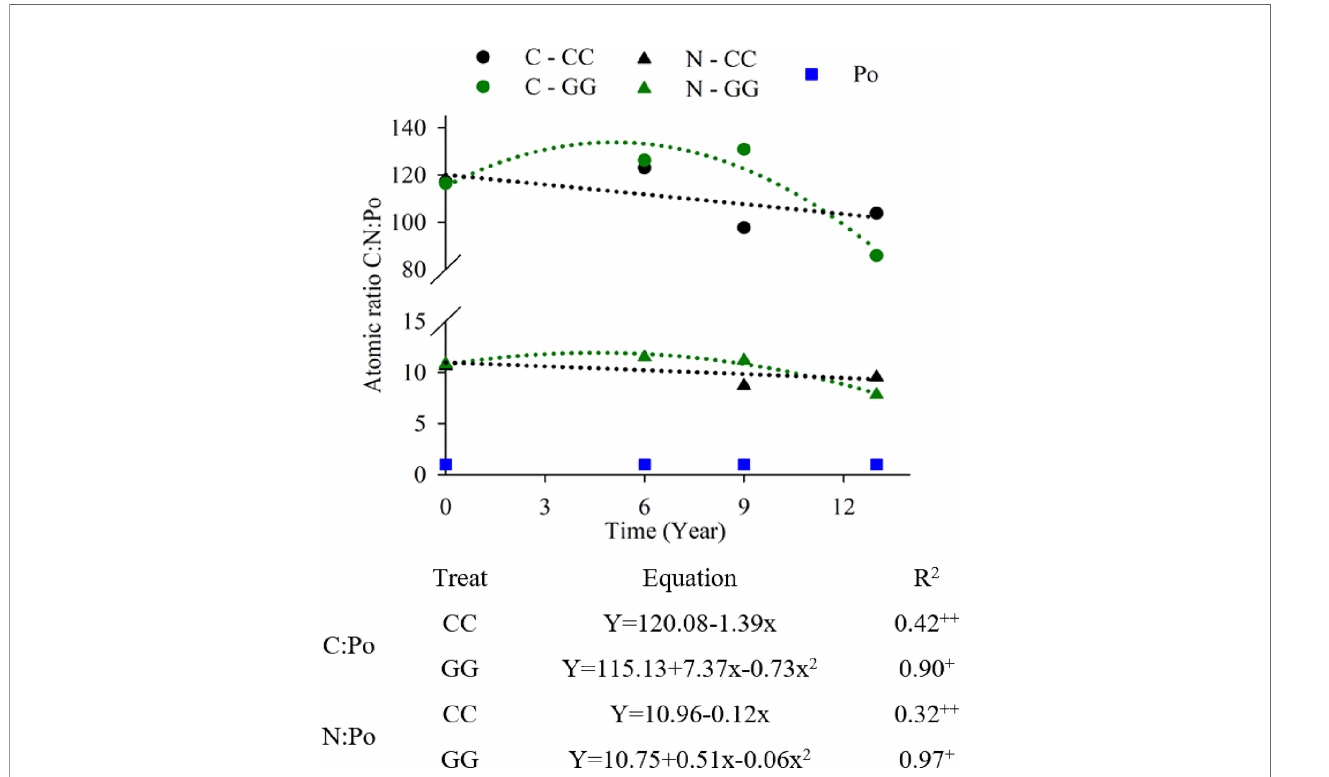
FIGURE 7 | Trends in the C:N:Po atomic ratio in the 0-30 cm topsoil layer under different soil management systems. + Signi fi cant at p ≤ 0.01. ++ Signi fi cant at p ≤